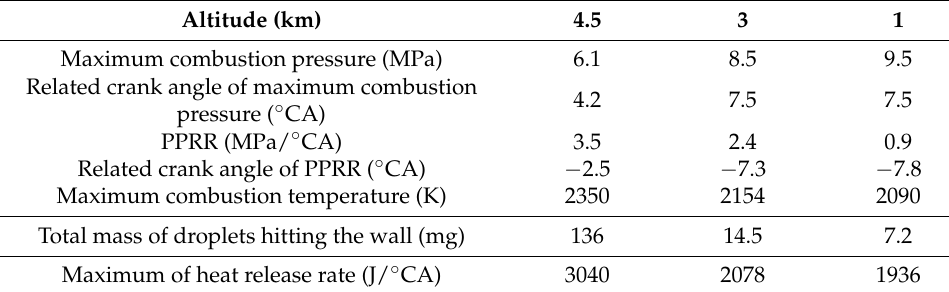
Figure 11. Comparison of integrated heat release at various altitudes. Table 3. Effects of altitude on combustion characteristic parameters.